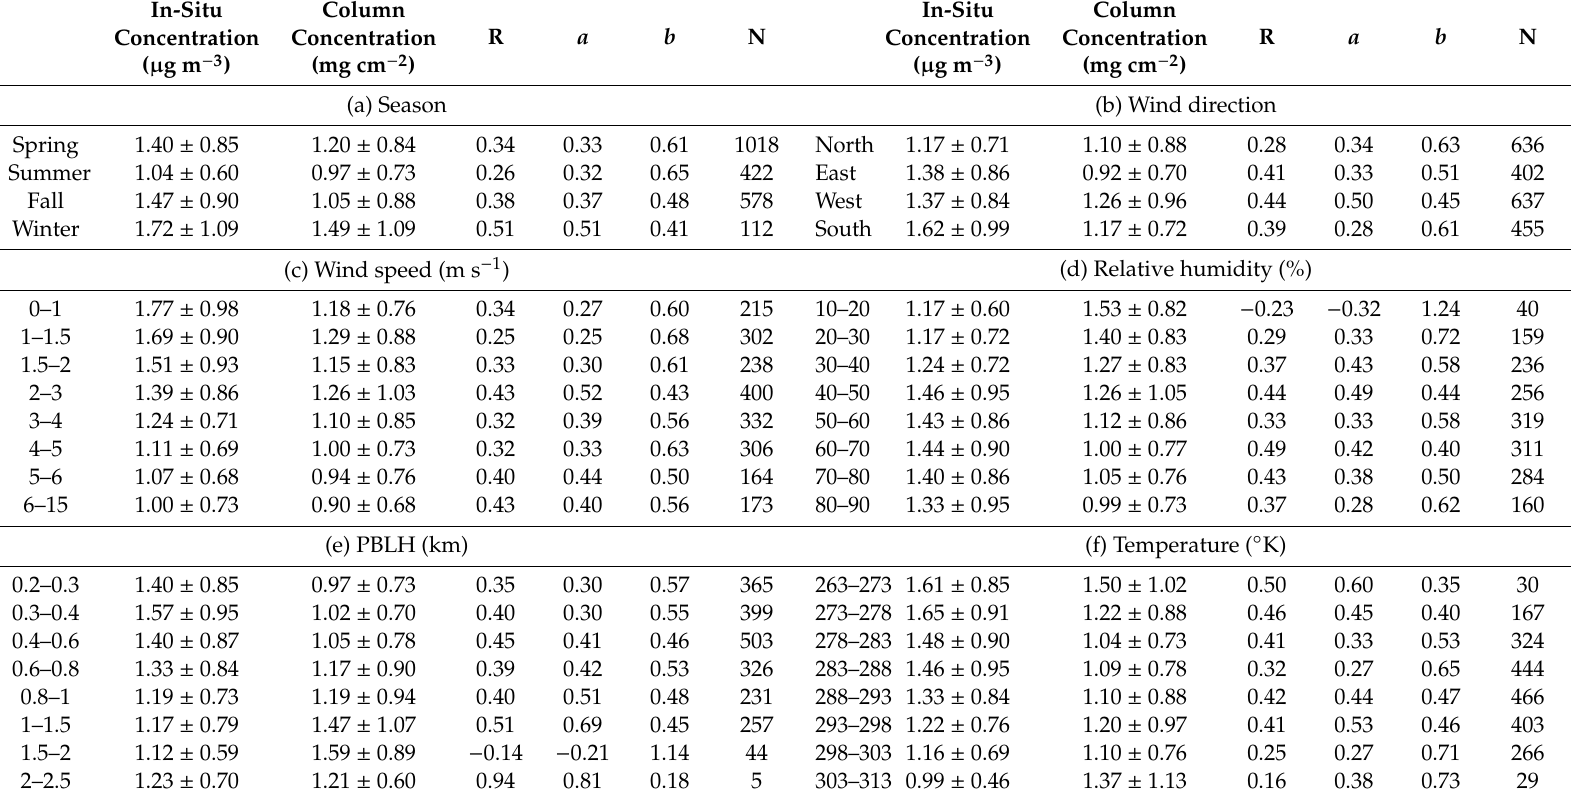
Table 4. Summary of statistical parameters for the relationship between the columnar and in-situ BC concentrations depending on the season and meteorological conditions. The parameters include the mean with standard deviation, correlation coe ffi cient (R), slope, and intercept of the linear regression line ( y = ax + b ), and